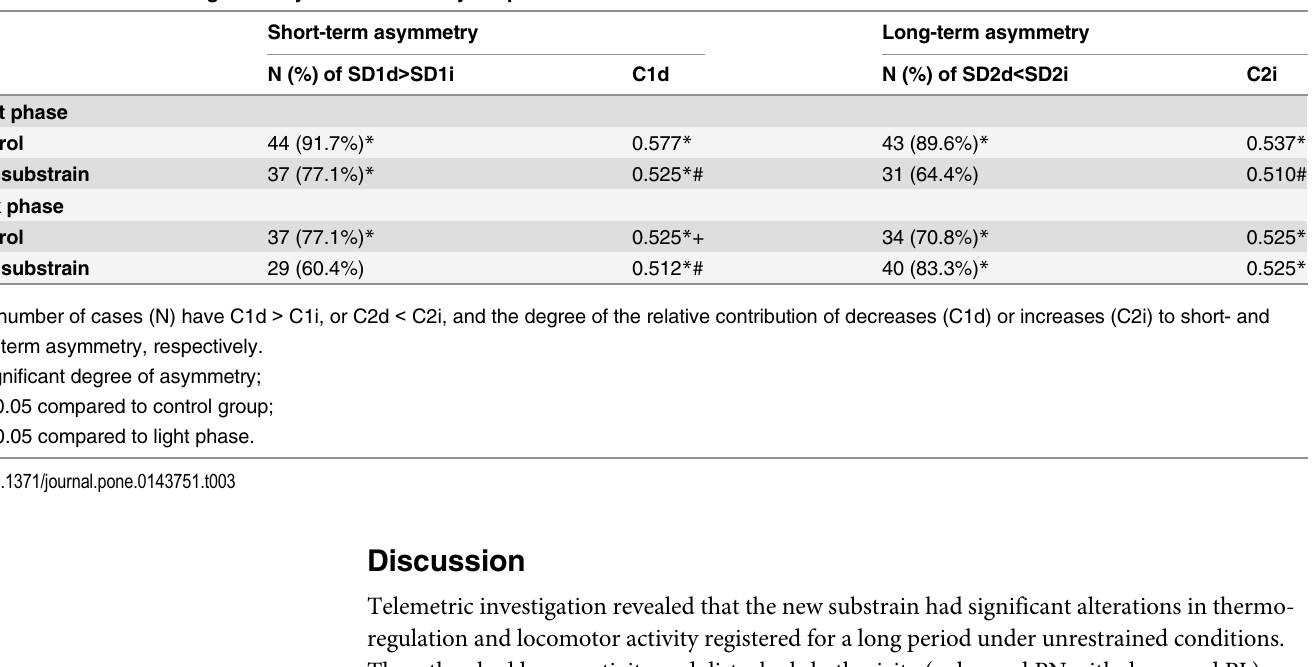
Table 3. The short- and long-term asymmetries of body